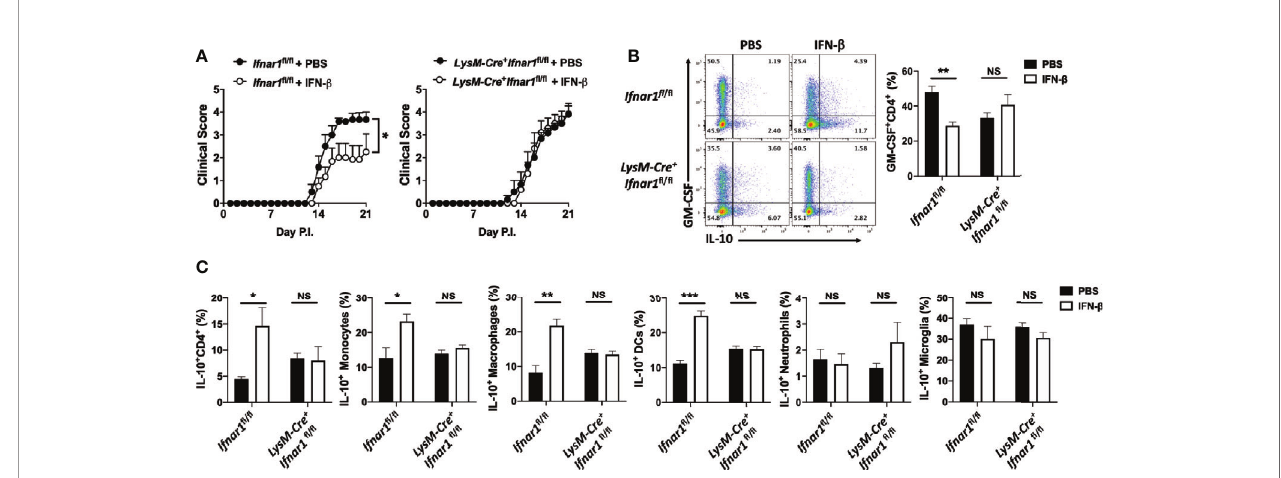
FIGURE 3 | rIFN- b acts on myeloid cells to suppress the development of EAE. Ifnar1 fl / fl and LysM-Cre + Ifnar1 fl / fl mice (n=6 per group) were immunized for EAE induction with MOG 35-55 and received daily i.p. injections of PBS or rIFN- b , sacri fi ced at day 21 p.i., and CNS cells were analyzed by fl ow cytometry. (A) Clinical severity score. (B) Representative fl ow cytometry dot plots showing GM-CSF and IL-10 expression by CD4 + T cells, and proportions (%) of GM-CSF + CD4 + T cells from the CNS. (C) Proportions (%) of IL-10 + CD4 + T cells, monocytes (CD45 hi CD11b + Ly6C hi Ly6G - ), DCs (CD45 hi CD11b - CD11c + MHCII + ), macrophages (CD45 hi CD11b + F4/80 + Ly6C - Ly6G - ), neutrophils (CD45 hi CD11b + Ly6C low Ly6G + ), and microglia (CD45 int CD11b + ) in the CNS. EAE experiments were conducted at least two times with similar outcomes. Data shown are mean ± SEM. For EAE, p-values were calculated using two-way ANOVA with Bonferroni ’ s multiple comparison correction. Parametric datasets were analyzed using unpaired Student ’ s t -test; *p < 0.05, **p < 0.01, ***p < 0.001, NS, not signi fi